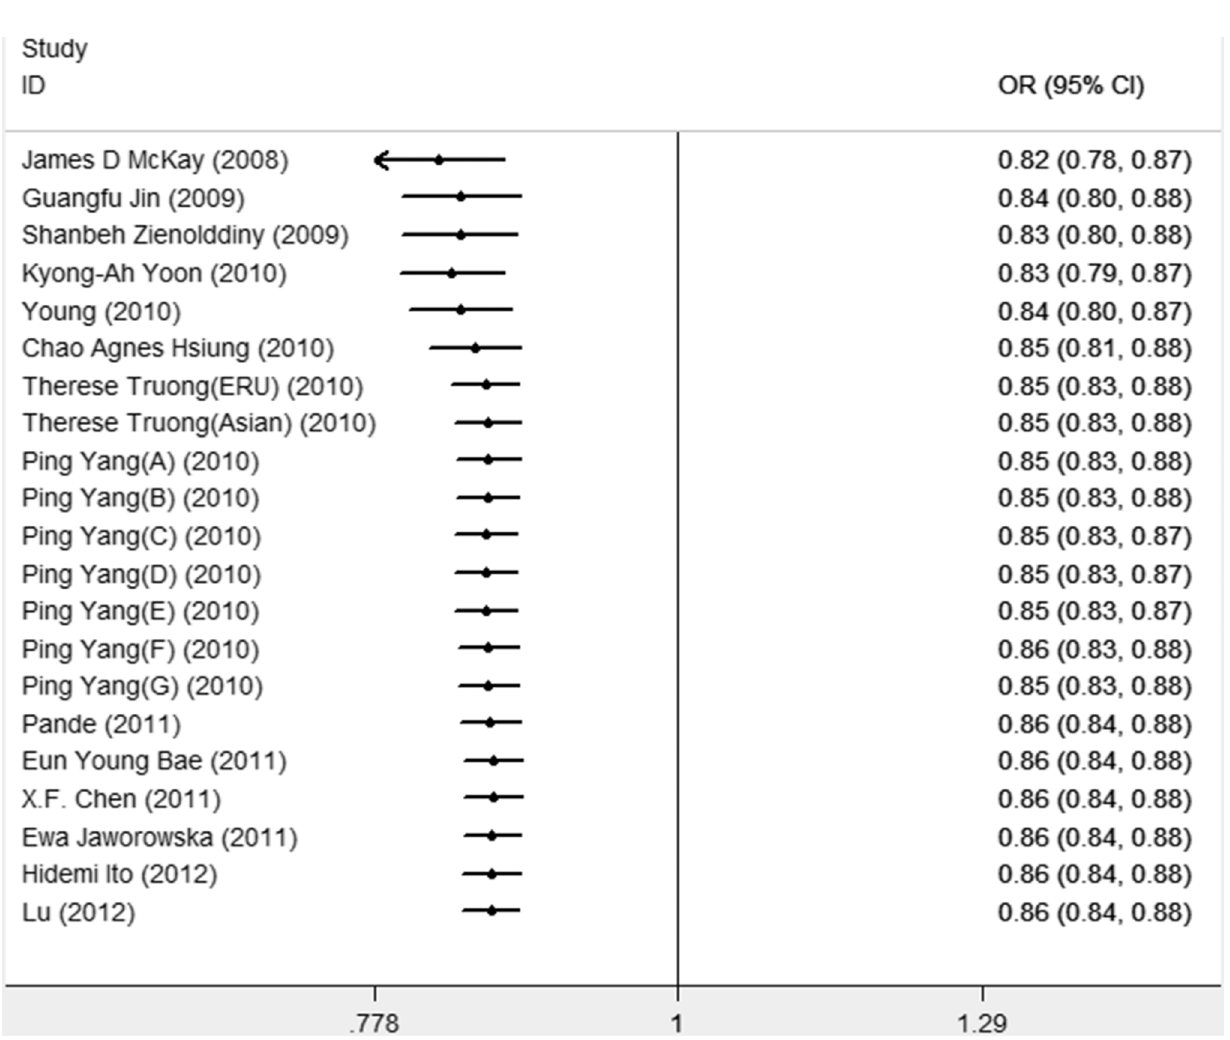
Figure 3. Cumulative meta-analysis of association rs402710 with lung cancer under allelic model.